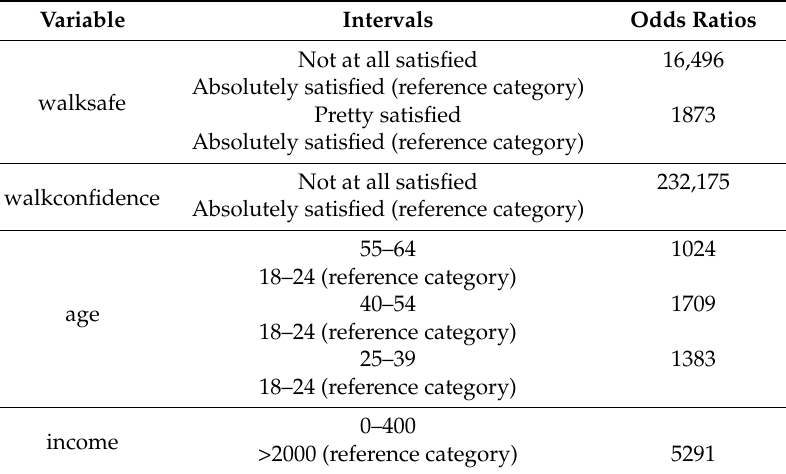
Table 8. Odds ratios results for the walking